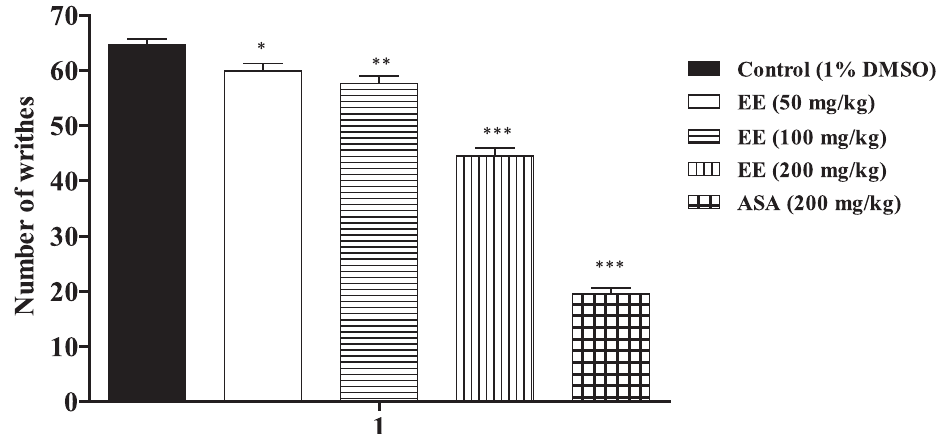
Figure 1 - Effects of the ethanol extract from A. fastigiatum branches on acetic acid-induced writhing in mice. The experimental groups were pre-treated 60 minutes previously to the beginning of experiment. ASA, acetylsalicylic acid. EE, ethanol extract. Data are mean ± S.E.M. of 8 mice. * p < 0.05; ** p < 0.01; *** p < 0.001 vs control